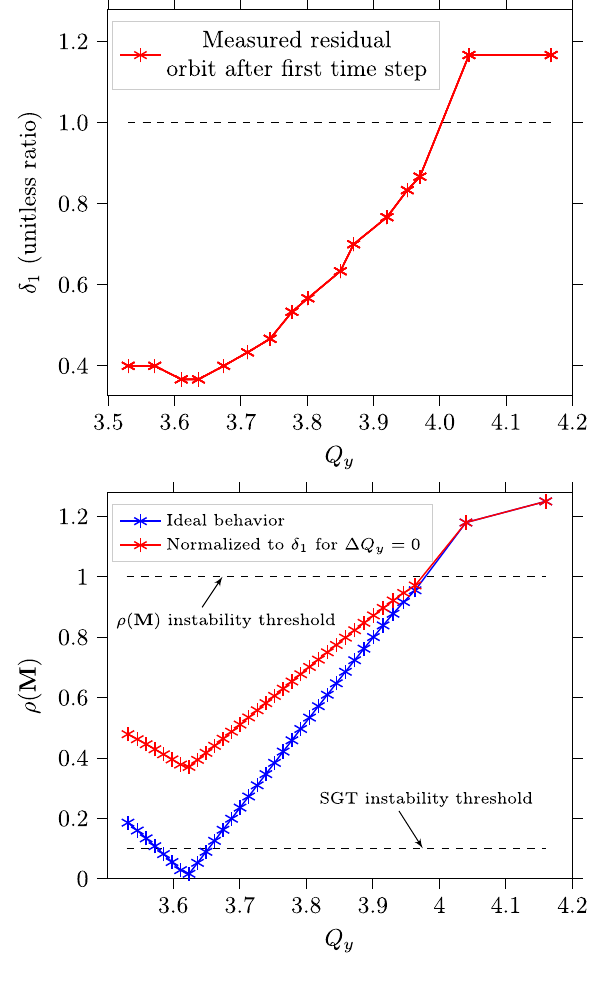
FIG. 11. Measured ratio δ 1 ¼ COSY for the fixed machine tune of Q the ORM in the feedback system corresponding to a tune range of 3.53 to 4.16 (top). Calculated ρ ð M Þ for vertical plane (bottom). For ideal and realistic case please see the text.